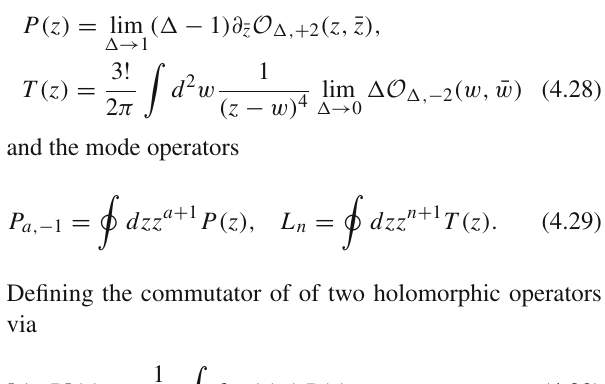
symmetries in Table 2 we define